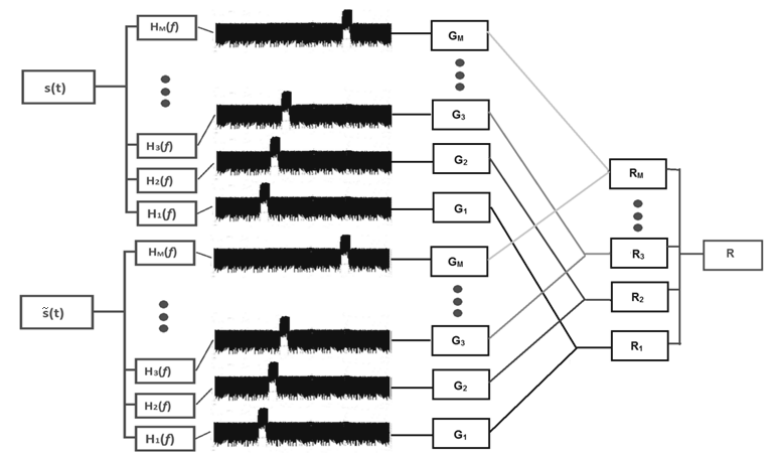
Fig. 1. Structural scheme of proposed